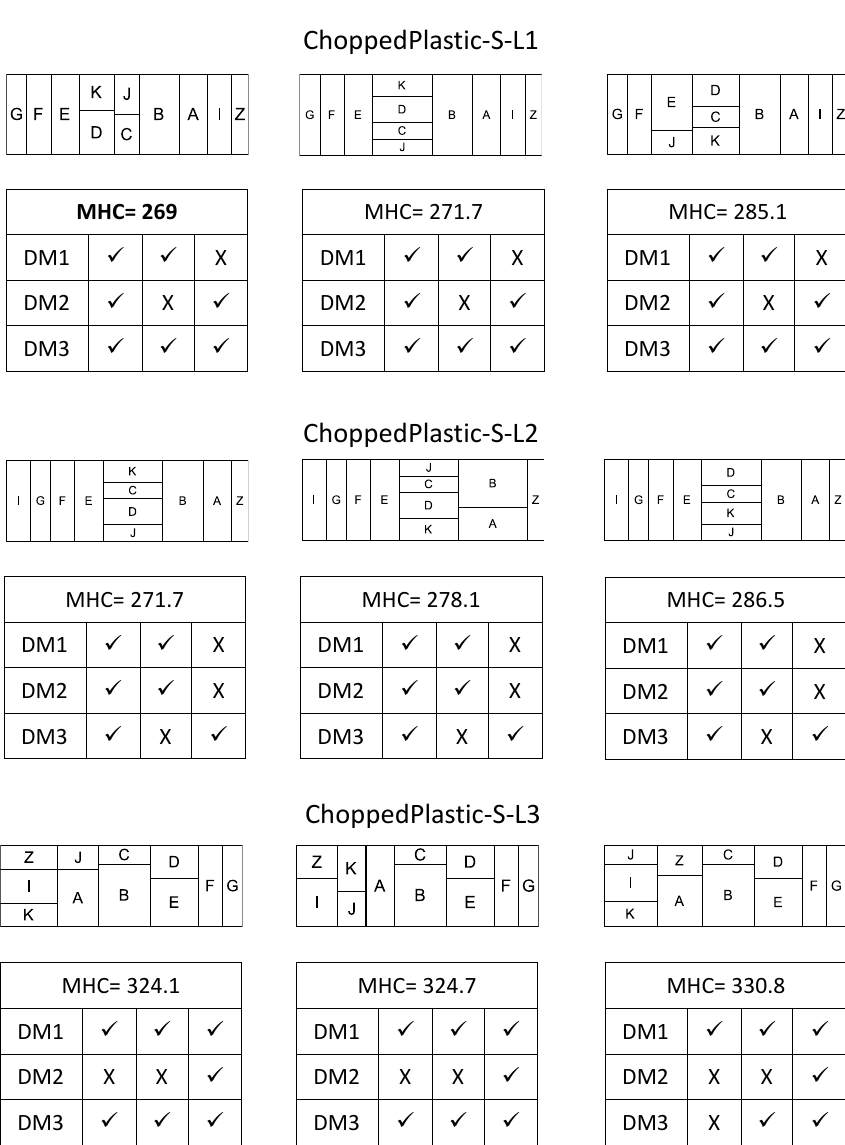
Figure 17. Best solutions found in Sequential launch 1 to 3 of ChoppedPlastic